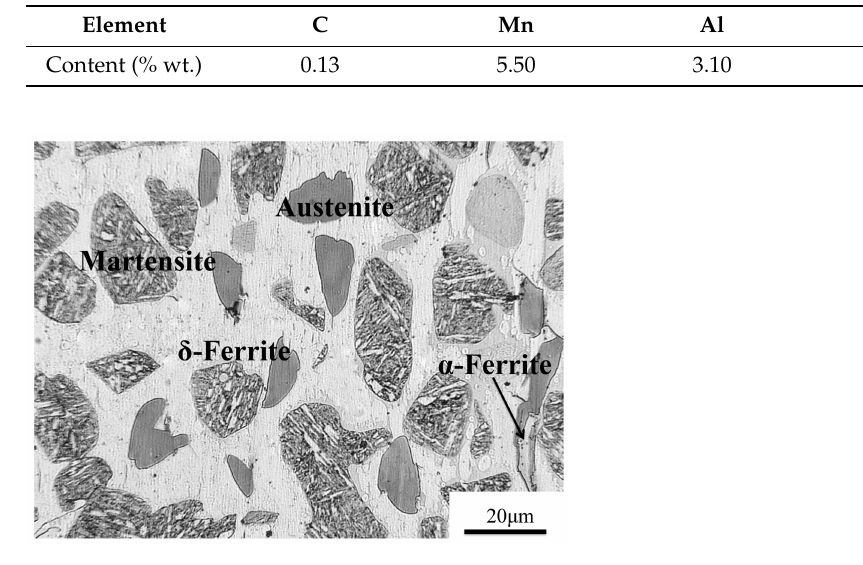
Figure 1. Microstructure of experimental steel.